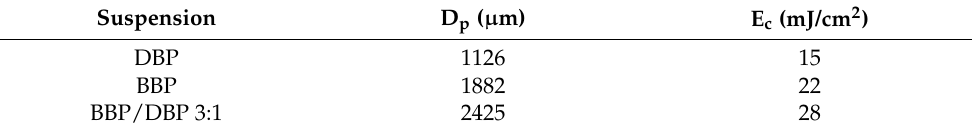
Table 6. Penetration depth and critical polymerization energy, calculated from Figure